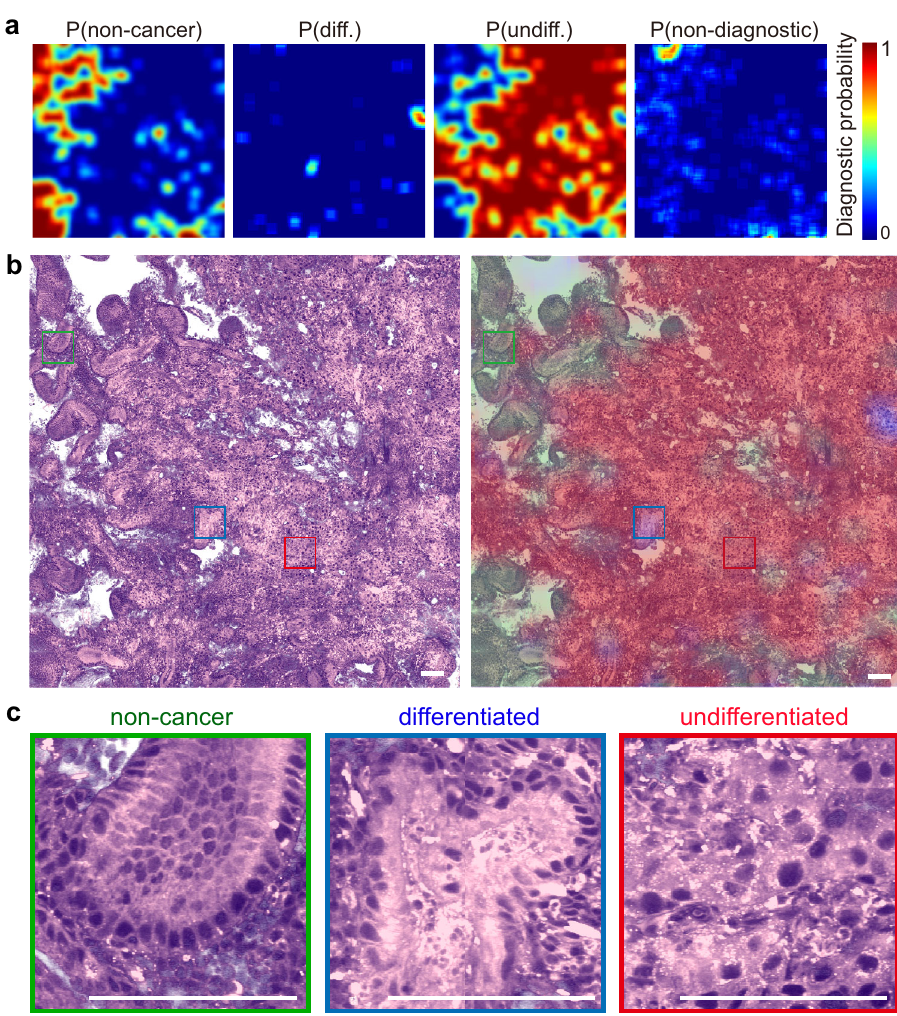
Fig. 6 Semantic segmentation reveals intratumor heterogeneity. a Spatial distribution of the prediction probabilities of each category; b Femto-SRH image and the segmented distributions of non-cancer (green), differentiated cancer (blue), undifferentiated cancer (red) and non-diagnostic (gray) regions; c Magni fi ed view of each category. Scale bars: 100 µ m. Source data are provided in the Source data fi